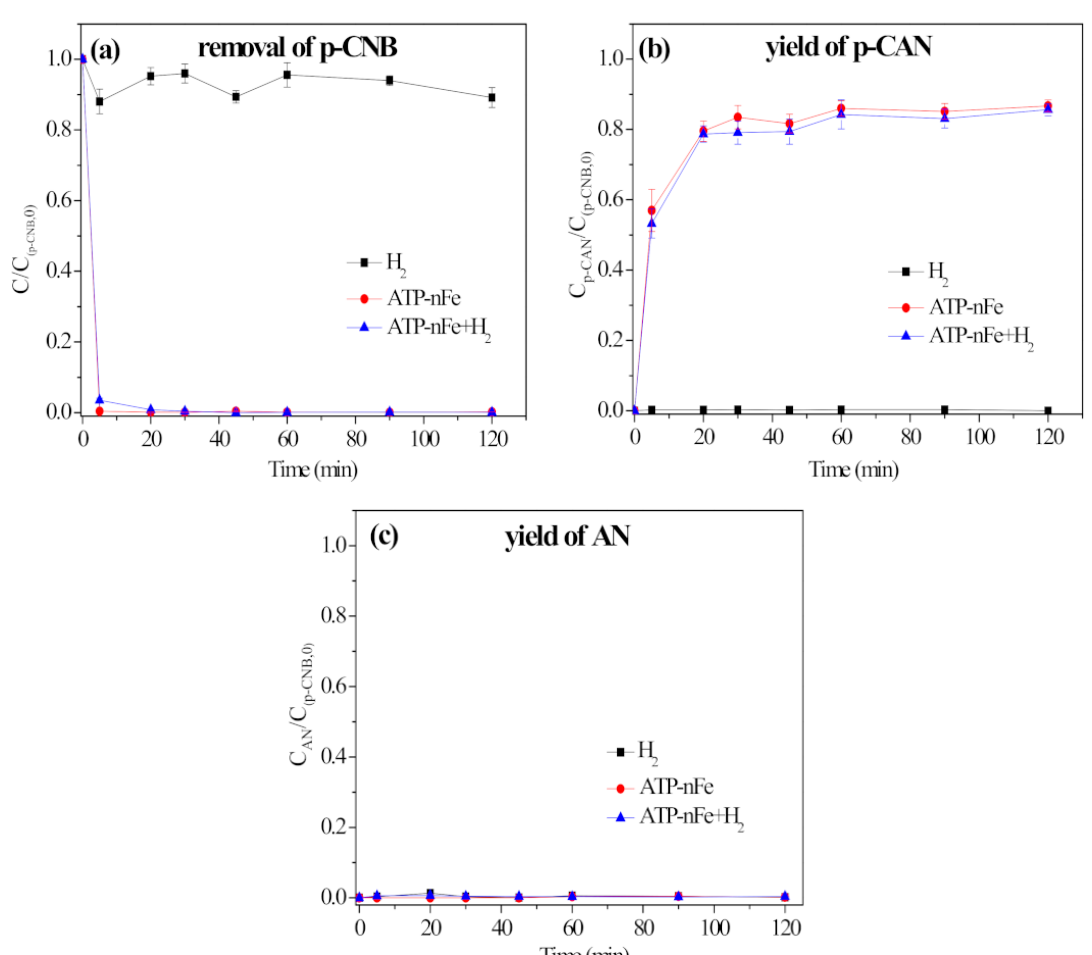
Figure 8. Removal of p-CNB by H 2 , ATP-nFe and ATP-nFe+H 2 ( a ), the yield of p-CAN ( b ) and the yield of AN ( c ) (reaction conditions: concentration of p-CNB = 10 mg/L, concentration of H 2 = 800 µ g/L, dosage of material = 0.5 g/L and initial pH = 5.6 ± 0.1).